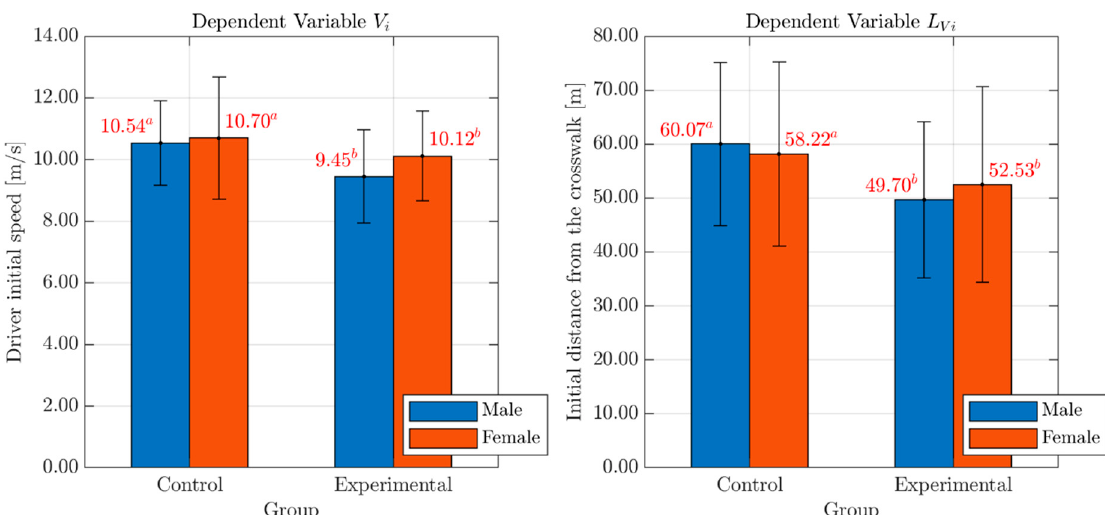
Figure 5. E ff ects of Gender and Group on the variables V i and L Vi . Legend : Red numbers above the Figure 5. Effects of Gender and Group on the variables (cid:1848) (cid:3036) and (cid:1838) (cid:3023)(cid:3036) . Legend : Red numbers above the bars represent mean values of the variables V i and L Vi , for males (blue bar) and females (red bar) in bars represent mean values of the variables (cid:1848) (cid:3036) and (cid:1838) (cid:3023)(cid:3036) , for males (blue bar) and females (red bar) in each Group. Statistically significant di ff erences are indicated by di ff erent superscript letters. Standard each Group. Statistically significant differences are indicated by different superscript letters. Standard deviation error bars are also reported for each deviation error bars are also reported for each sub-group.